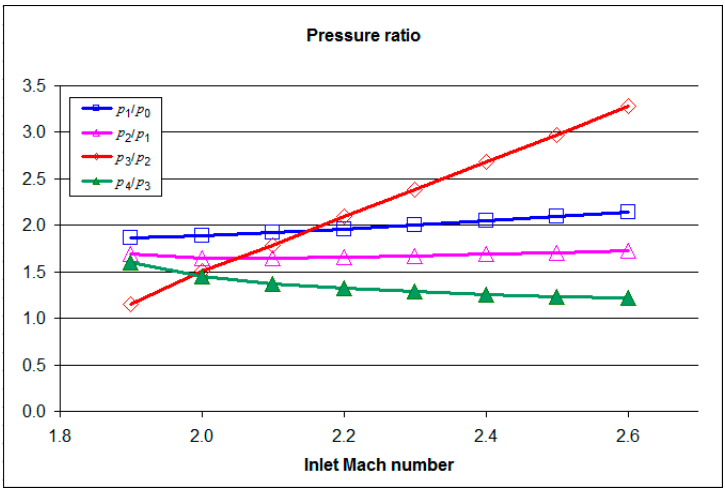
Figure 6. Local values of compression ratios in the following cross-sections: after the primary oblique shockwave ( p 1 / p 0 ), after the secondary oblique shockwave ( p 2 / p 1 ), after the normal shockwave ( p 3 / p 2 ), and for the combustion chamber inlet cross-section ( p 4 / p 3 ).